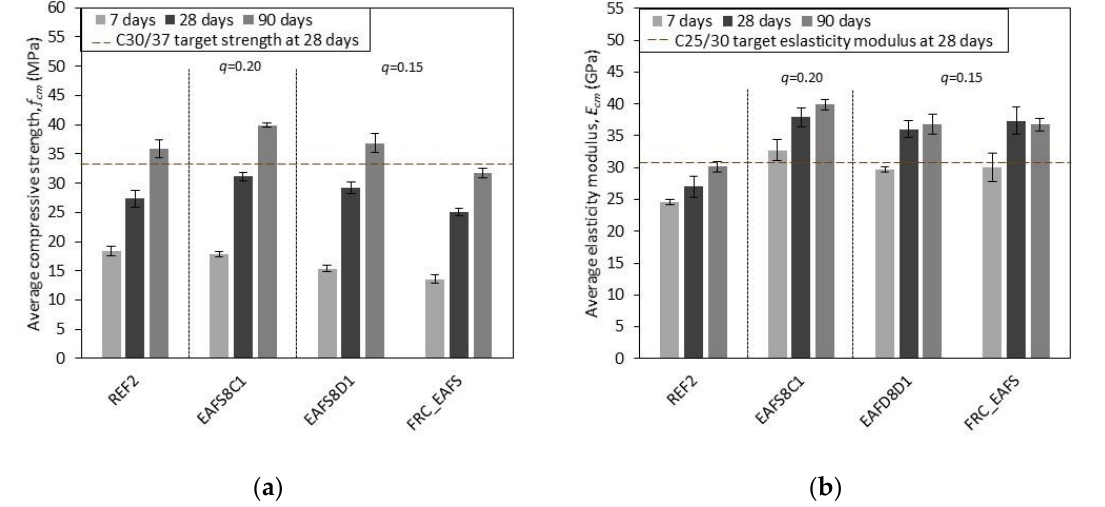
Figure 12. Mechanical testing results of REF2, EAFS8C1 and EAFS8D1 mixtures at 7, 28 and 90 days after casting, with lower cement amount: ( a ) average compressive strength, f cm ; ( b ) average elasticity modulus, E cm .